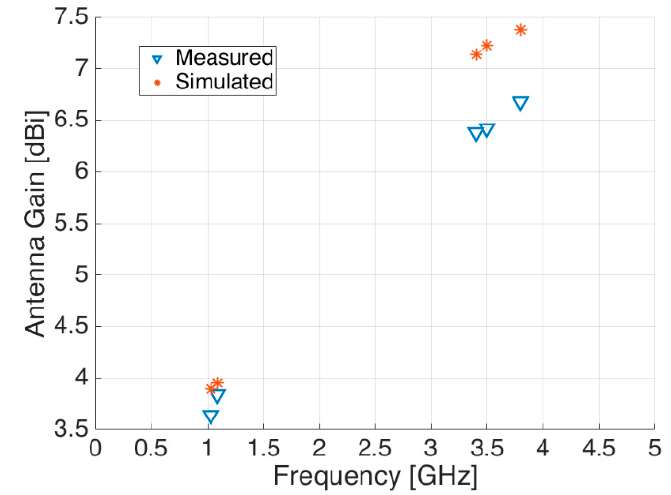
Figure 18. Antenna gain—measured (blue triangle) and simulated (red asterisk).